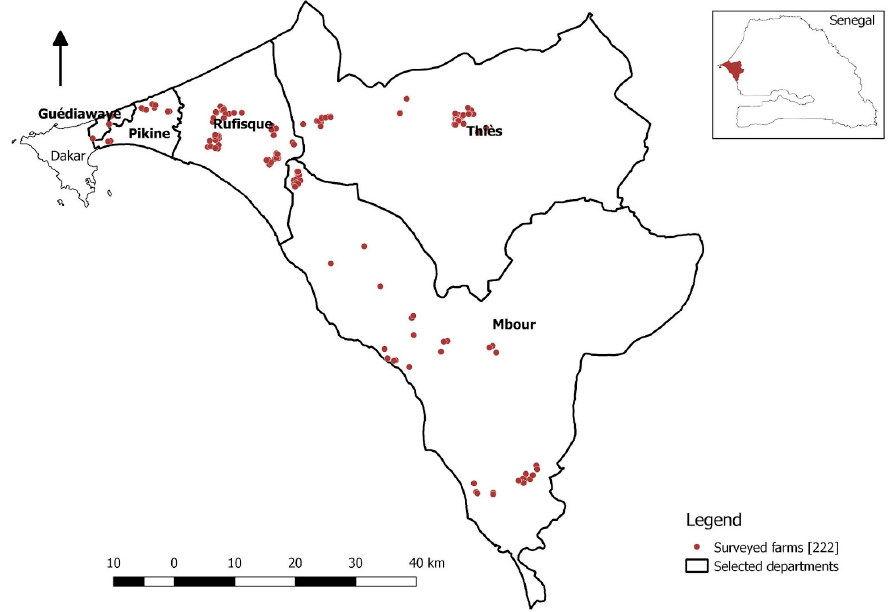
Figure 2. Map of the farms surveyed and the selected area.